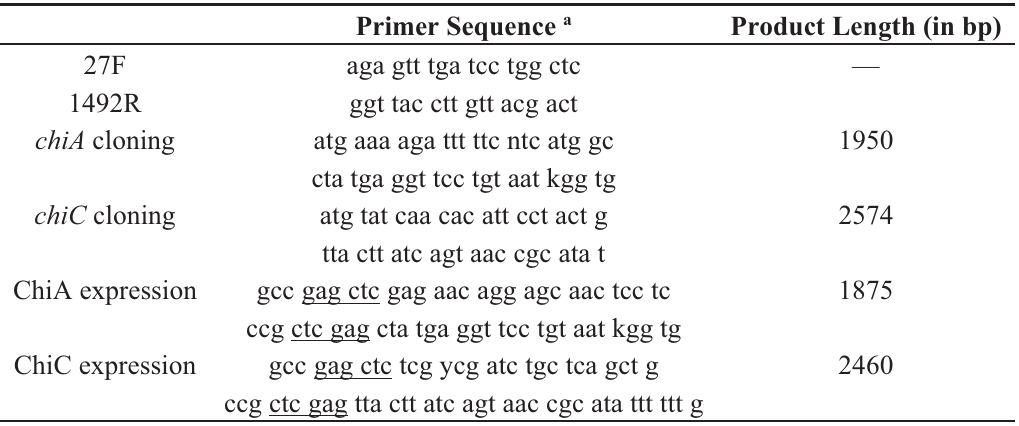
Table 1. Primers used in this